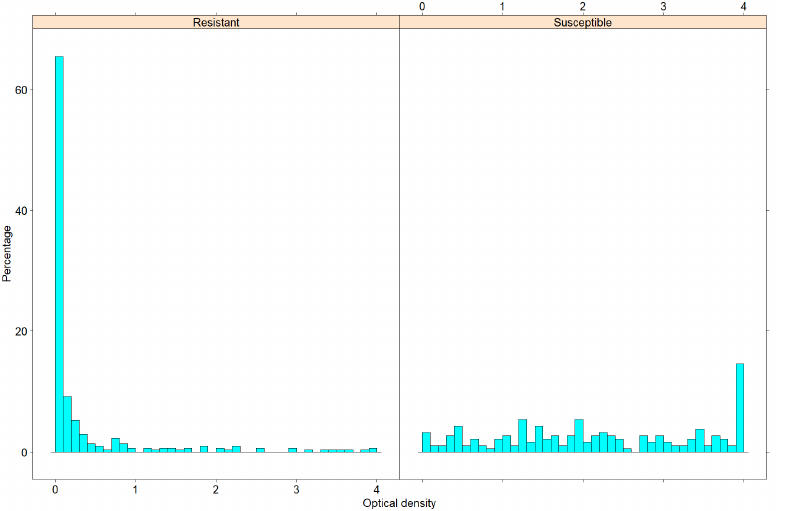
Figure 1. Histograms of optical density (OD) values for each of the six sugar beet genotypes. The X axis represents OD values in the range from 0 to 4 with a binning width of 0.1. The Y axis represents percentage of measurements in each bin.